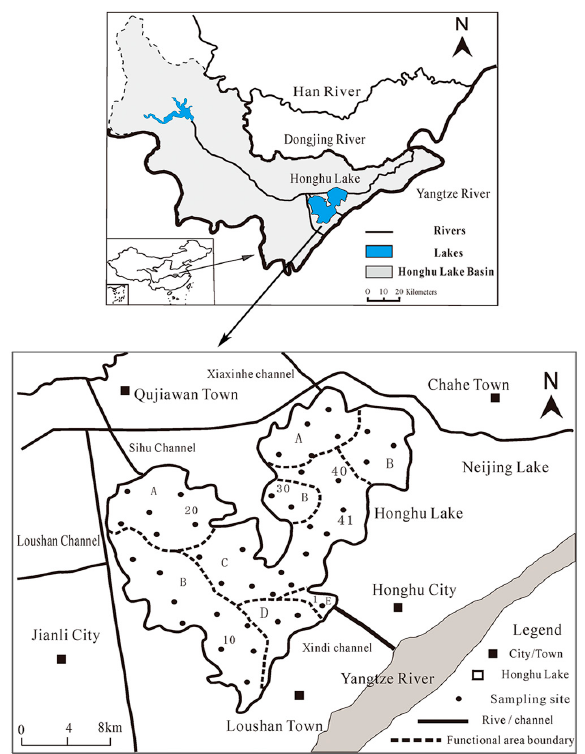
Figure 1. Location, sample sites and different areas of Honghu Lake: A: river inflow areas; B: enclosure culture areas; C: open water area; D: lake protection area; and E: area connecting to the Yangtze River.